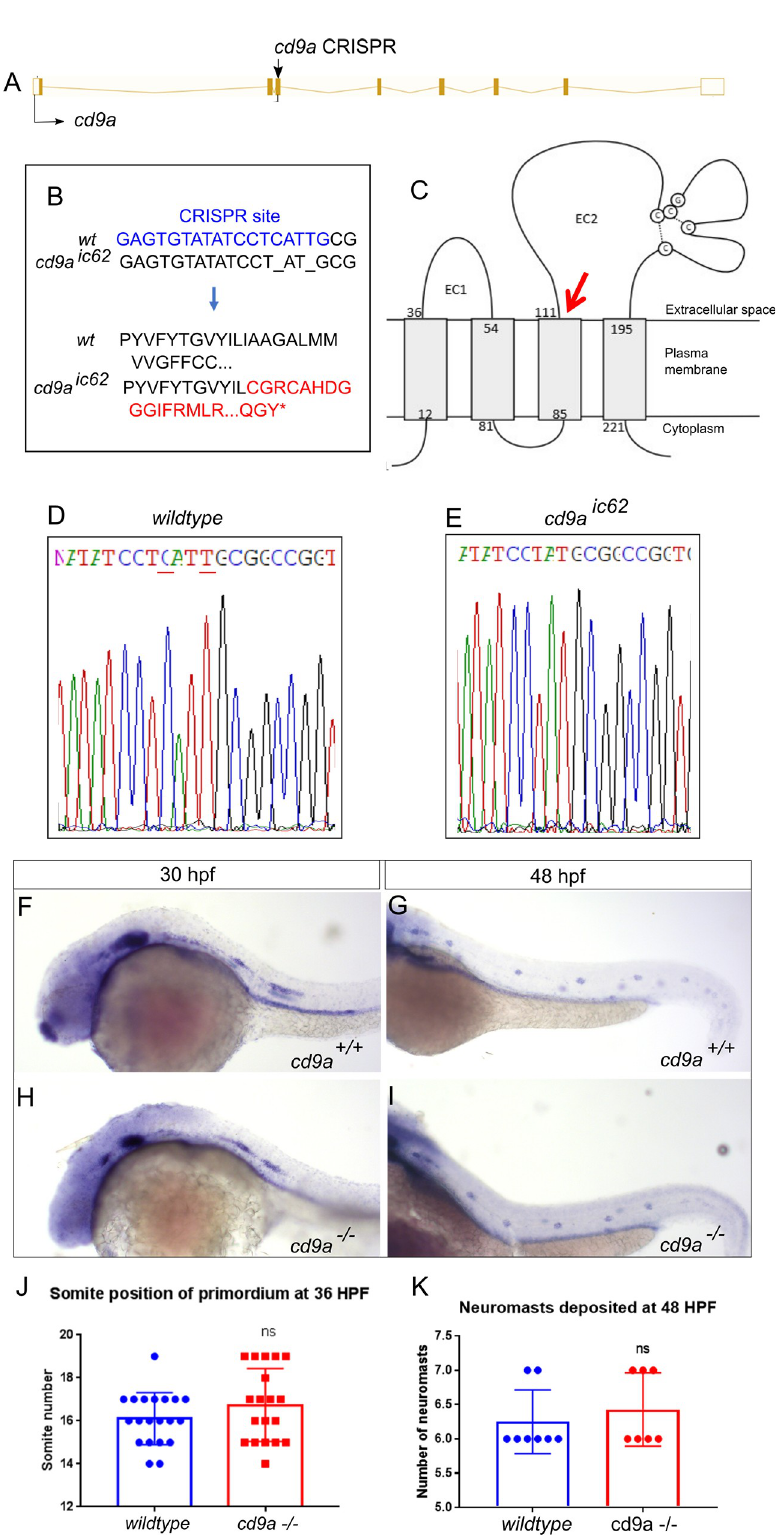
Fig 4. Generation of cd9a mutant does not show any abnormal pLLP development. A: Nature of the cd9a mutant allele showing CRISPR site location within the intron-exon structure of the gene. B: The CRISPR target sequence in exon 3 is shown in blue; the 2bp deletion in the cd9a allele is indicated under the WT sequence as dashes. This leads to